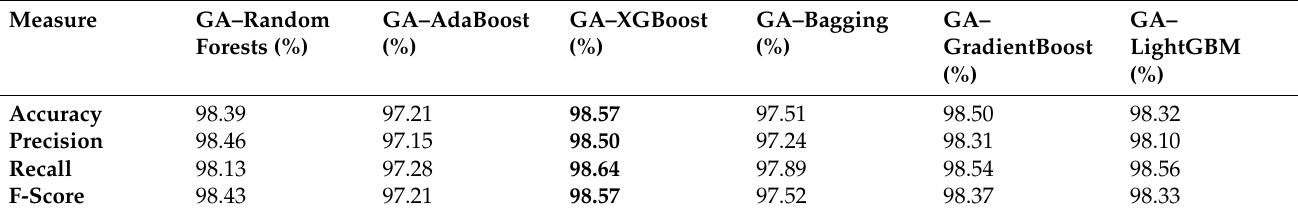
Table 9. Performance of GA-based ensemble classifiers for Dataset 2.